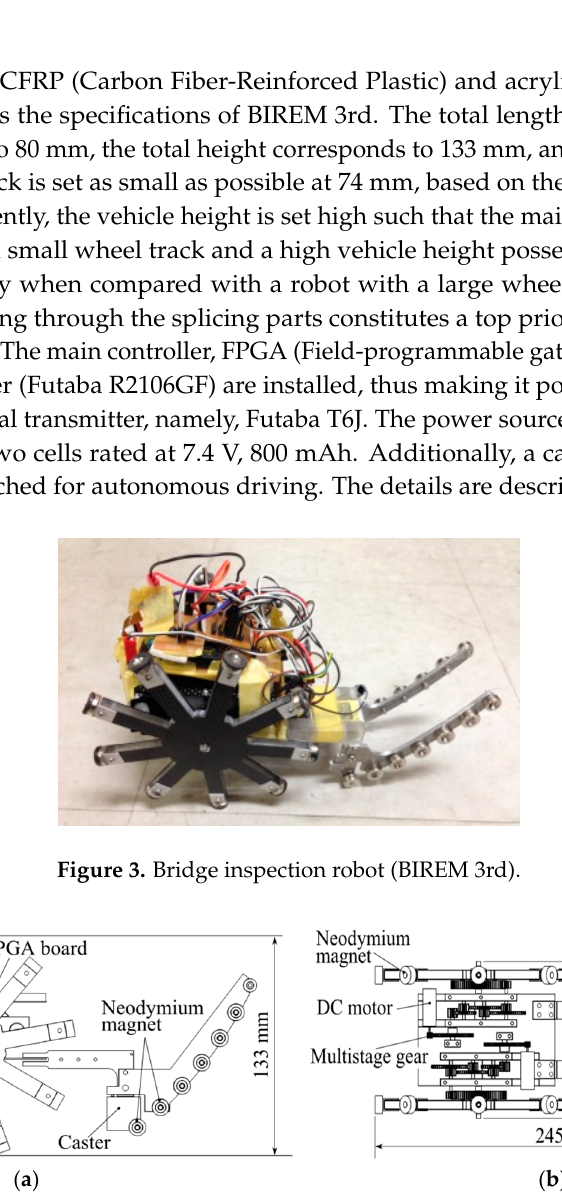
Figure 4. Mechanism of BIREM 3rd. ( a ) Side view; ( b ) top view. Table 1. Specifications of BIREM 3rd. FPGA, field-programmable gate array.